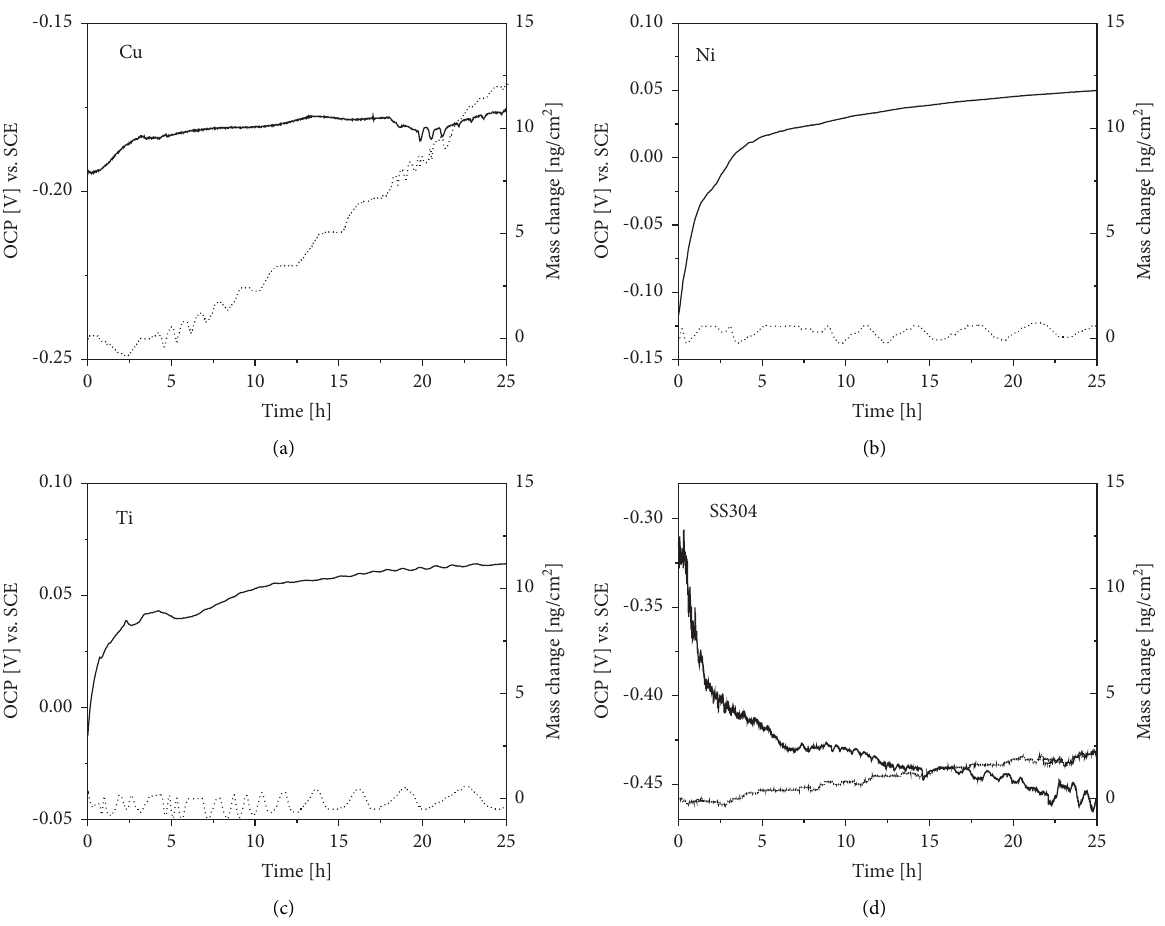
Figure 3: OCP (solid line) and mass change (dash line) of (a) Cu, (b) Ni, (c) Ti, and (d) SS304 in 0.1 M NaCl − added oxic KURTgroundwater solution.